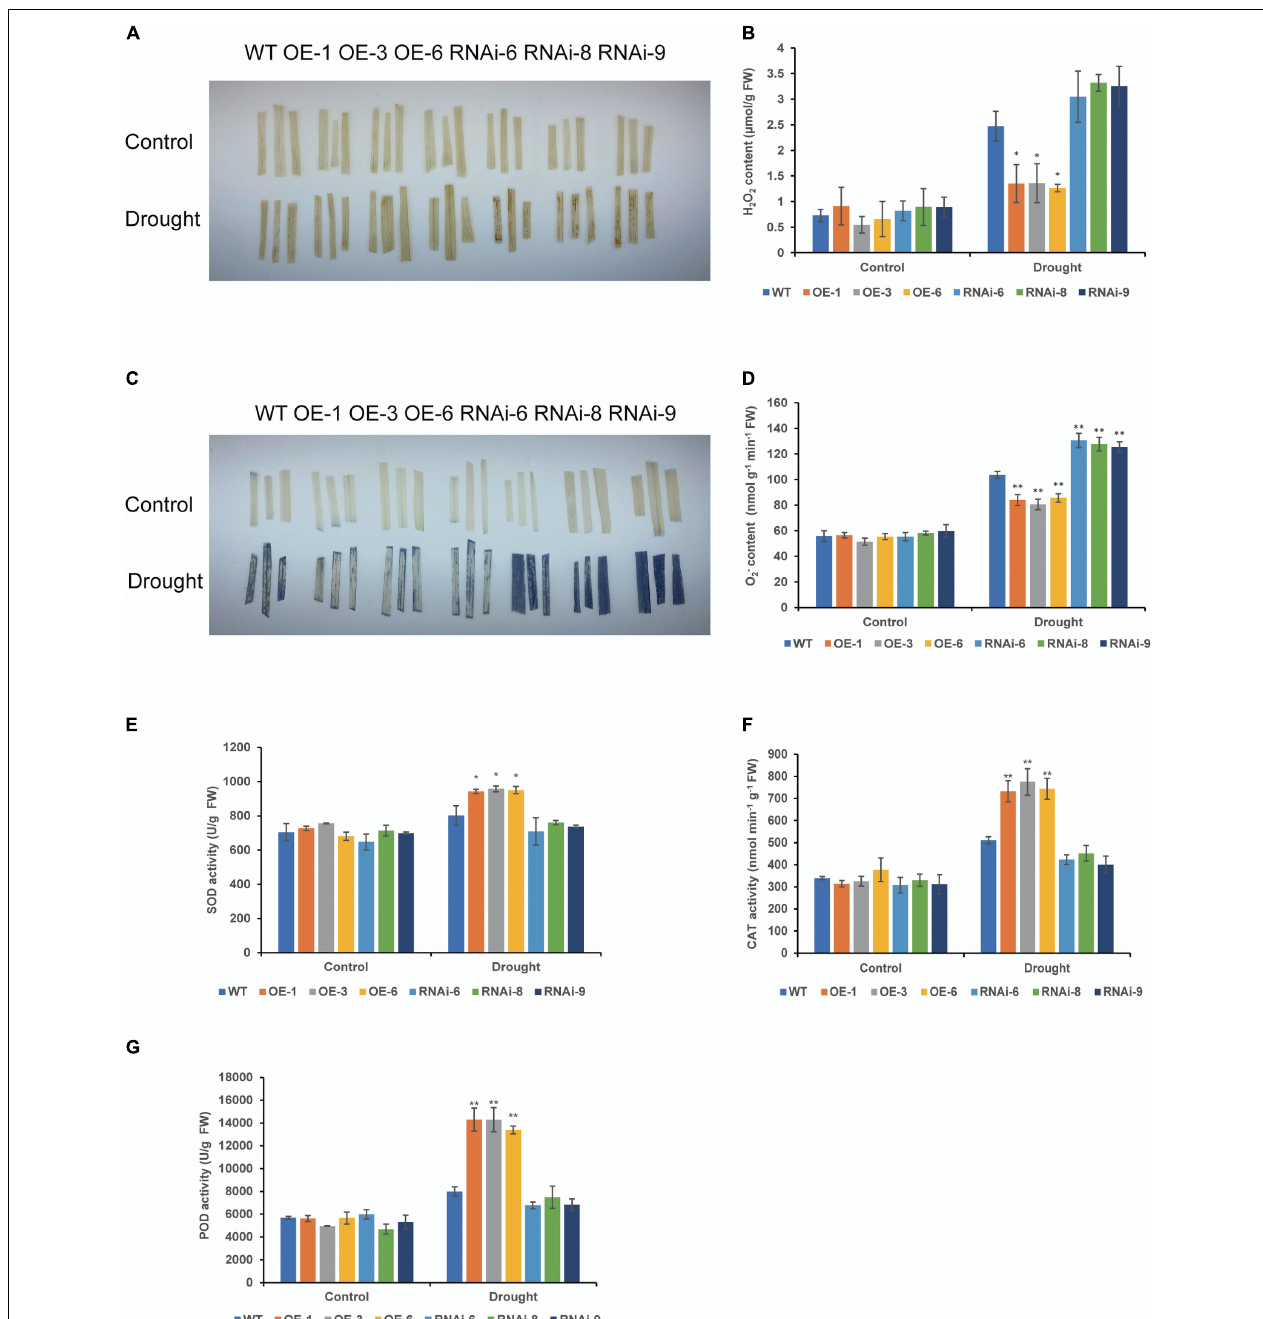
FIGURE 6 | Effect of drought stress on the ROS of WT and transgenic wheat. (A) Histochemical staining was used to detect H 2 O 2 by DAB staining with 4 weeks WT and TaNRX1 transgenic wheat in normal water supply and 10 days of drought stress. (B) H 2 O 2 content ( n = 3). (C) Histochemical staining was used to detect O 2 - by NBT staining. (D) O 2 - content ( n = 4). (E) Superoxide dismutase (SOD) content ( n = 4). (F) Catalase (CAT) content ( n = 3). (G) Peroxidase (POD) content ( n = 4). Data represent the mean ± SD. WT, wild type; OE-1–OE-6, TaNRX1 overexpression T 3 homogeneous lines; RNAi-6–RNAi-9, TaNRX1 RNA interference T 3 homogeneous lines. * P < 0.05, ** P < 0.01 represent the significant difference between the transgenic line and the WT, respectively.